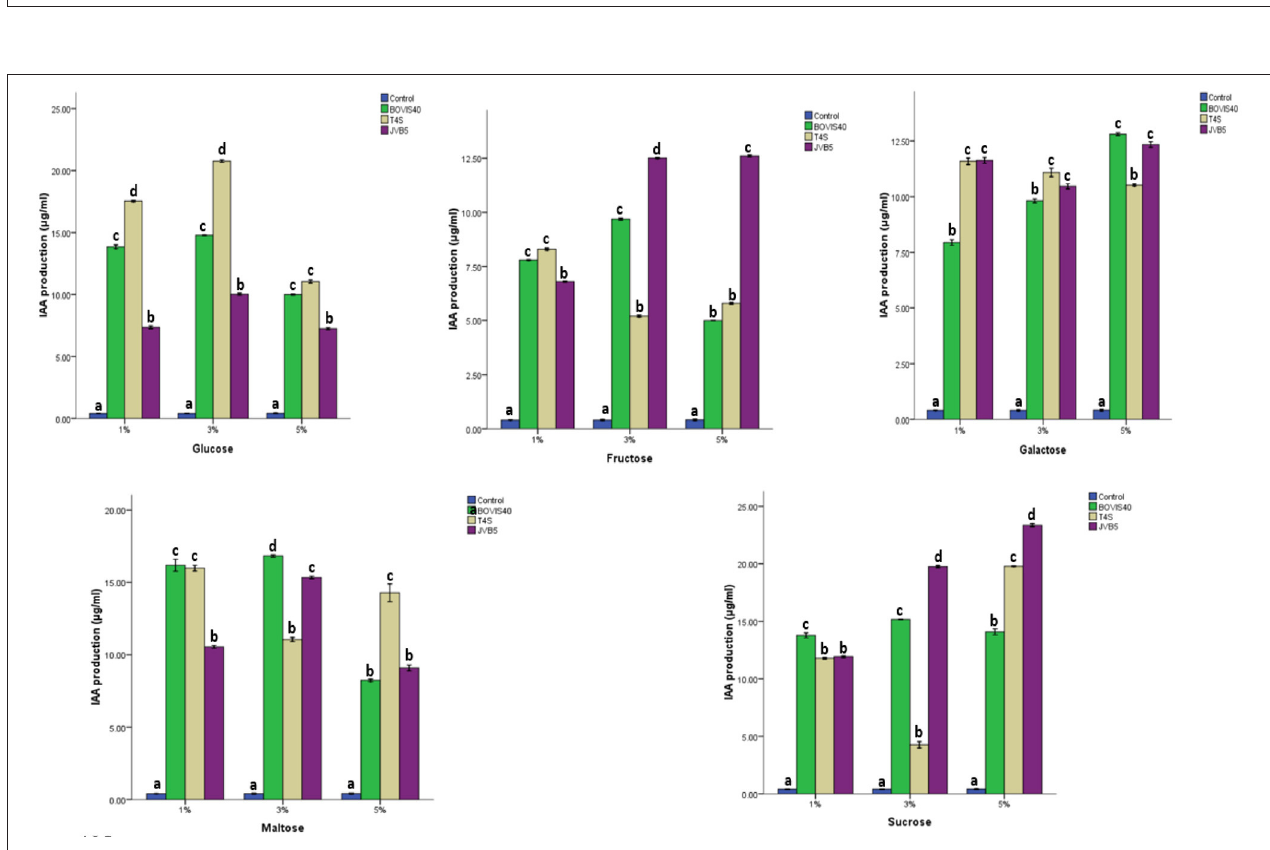
FIGURE 8 | Effect of different carbon source on IAA production by endophytic bacteria. The different alphabets indicate significant differences in triplicate readings.